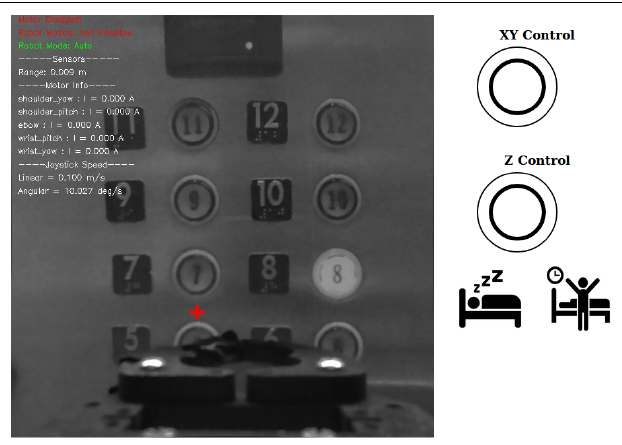
Figure 7. RoboticarmGraphicalUser